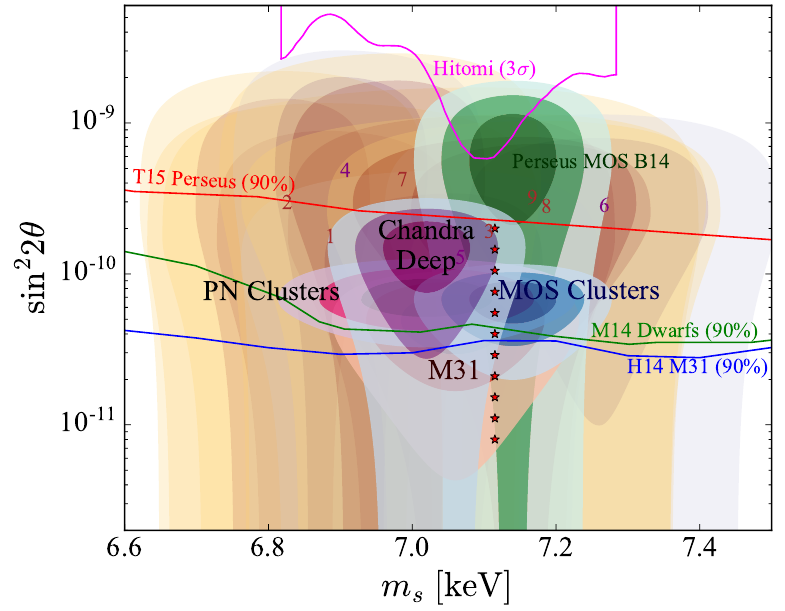
Figure 16. The allowed parameter space for sterile neutrinos obtained from the X-ray emission. The colored regions are 1, 2 and 3 σ confidence levels. Numbers from 1 to 9 mark the center of the 2 σ region detections obtained using nine galaxy clusters [386]. The lines show constraints at the 90% confidence level from Chandra [381], Suzaku [383] and dwarf galaxies dataset [382]. The stars represent several models of sterile neutrino. The figure is reproduced from